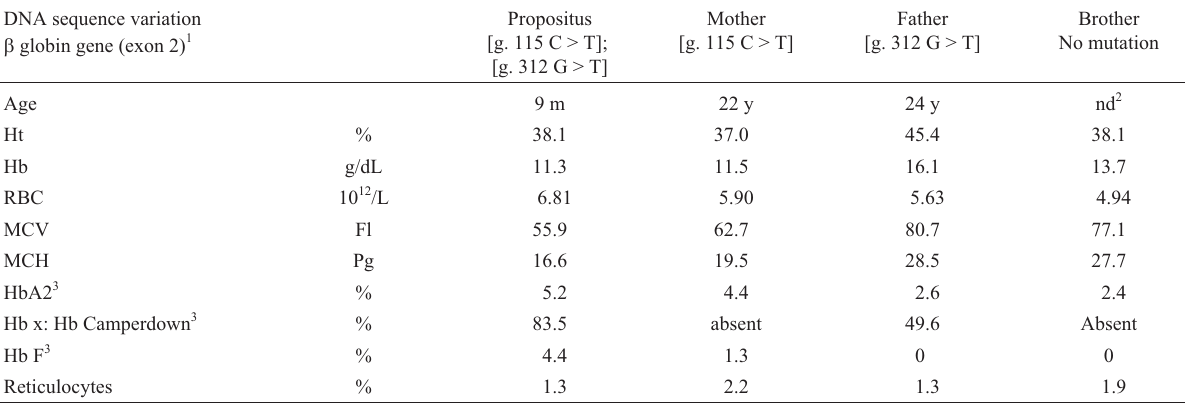
Table 1 - Molecular, biochemical and hematological data. DNA sequence variation (cid:1) globin gene (exon 2) 1